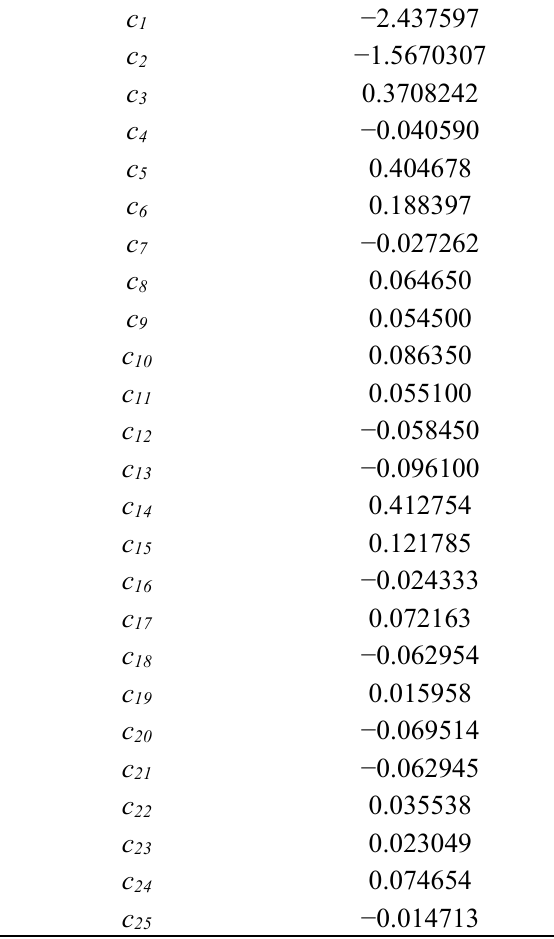
Table A1. Coefficients of the CMOD-IFR2